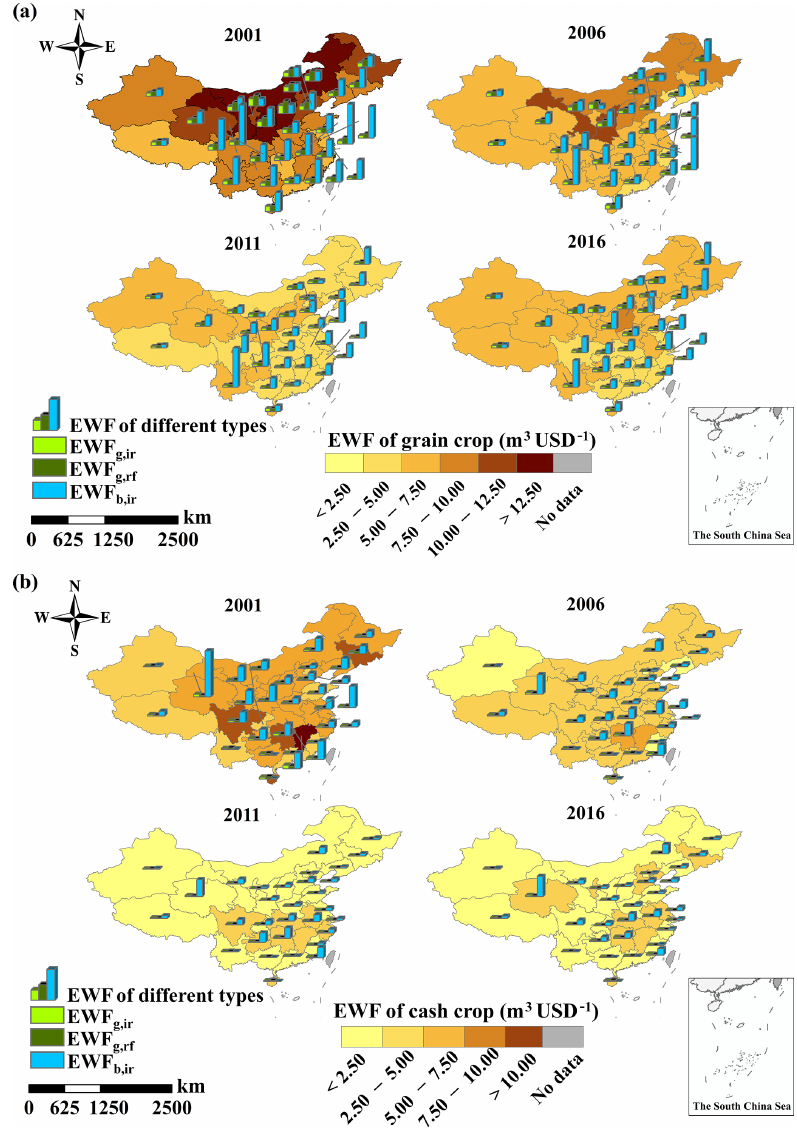
Figure 6. Temporal and spatial evolution of economic value-based water footprint (EWF) of (a) grain and (b) cash crops in China.